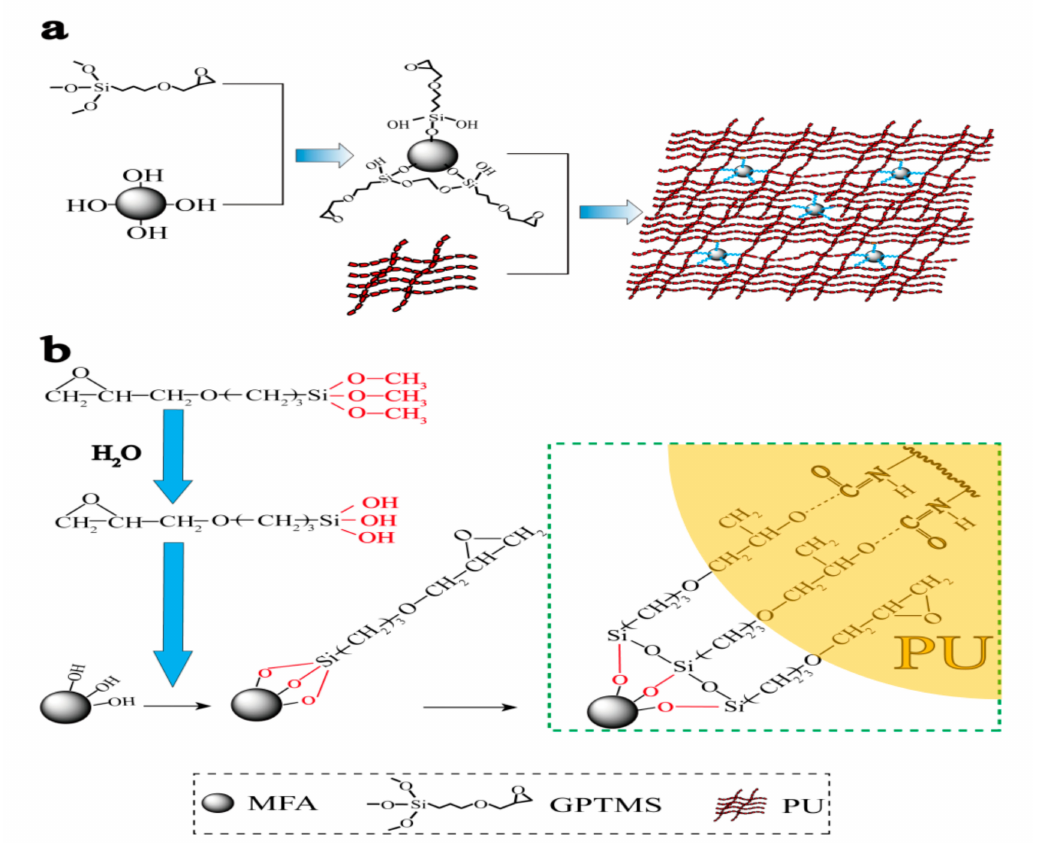
Figure 3. Schematic illustration of the synthesis of PU / MFA composites ( a ) and the crosslink mechanism of modified MFA by 3-Glycidoxypropyltrimethoxysilane (GPTMS) and PU matrix ( b